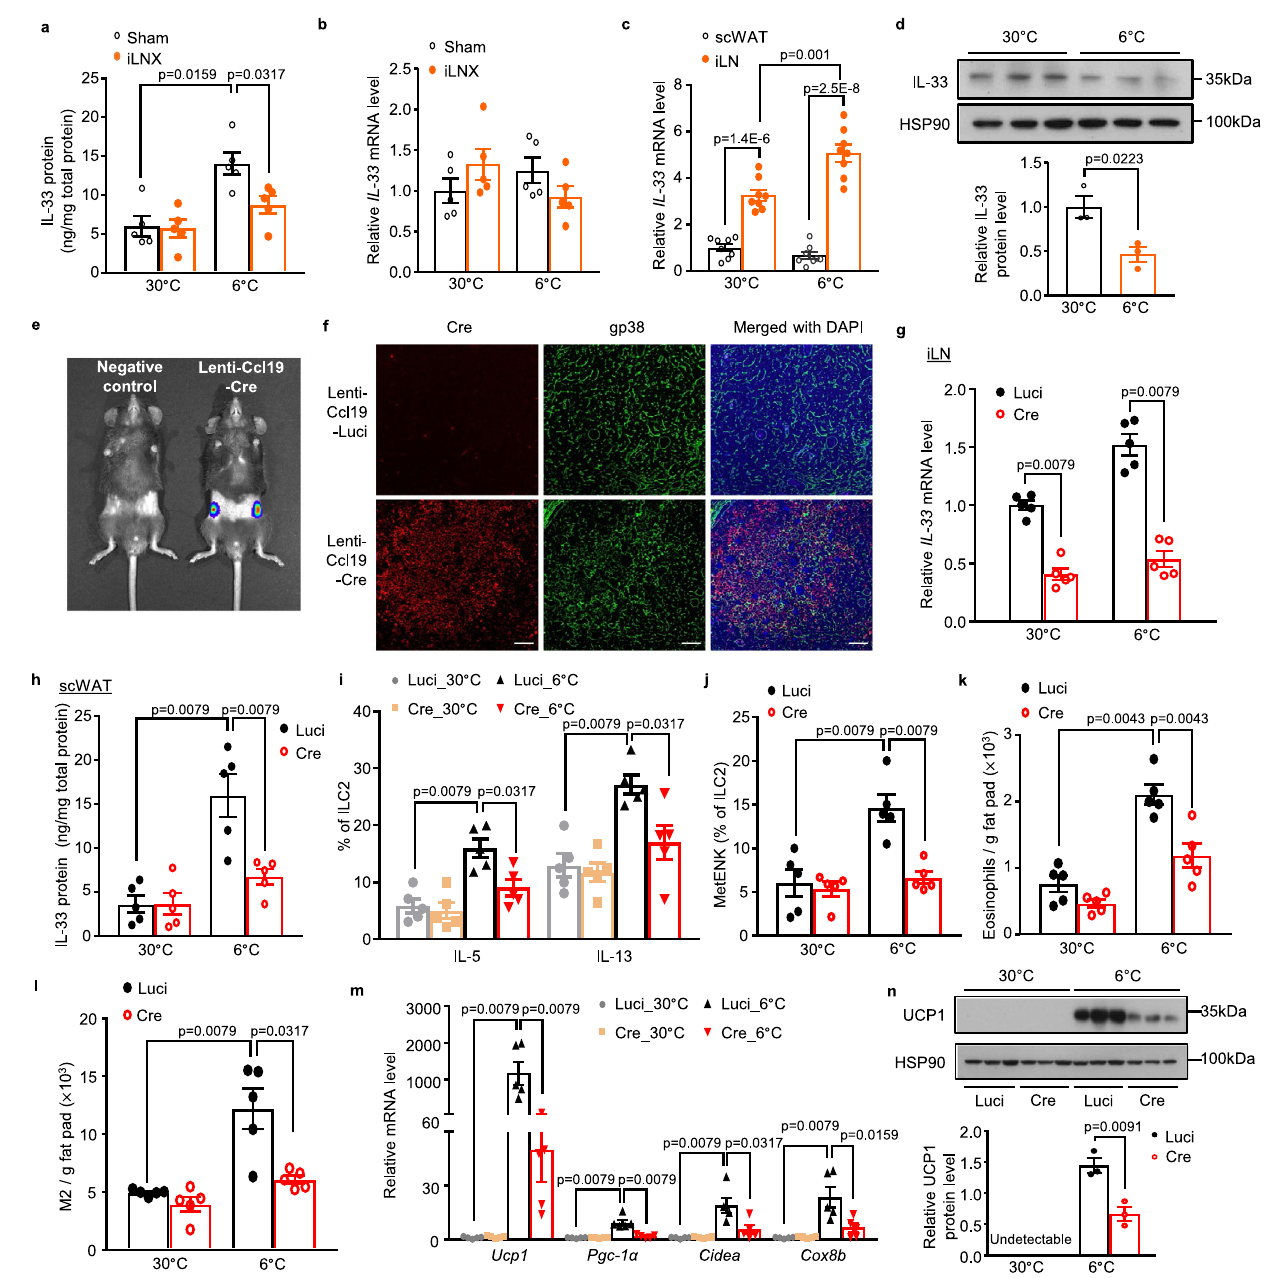
Fig. 3 | iLN FRC-derived IL-33 is indispensable for cold-induced activation of ILC2s and beiging of scWAT. a – d Sham-operated and iLNX male C57BL/6N mice wereexposedto6°Cor30°Cfor2days. a , b ELISAanalysisofproteinlevel(a)and themRNAexpressionofIL-33( b )inscWATofsham-operatedandiLNXmice( n =5). c The mRNA level of IL-33 in scWAT and iLN ( n =8). d IL-33 protein level in iLN determined by Western blot (top) and densitometric quanti fi cation of IL-33 (bot- tom) ( n =3). e – n Lentivirus encoding FLAG-tagged Cre and luciferase (Lenti-Ccl19- Cre)orluciferase only(Lenti-Ccl19-Luci)drivenby the Ccl19promoterwas directly injected into iLNs (7.5×10 6 Transduction Units [TU] per side) of eight-week-old male IL33 fl / fl mice. Seven days after lentiviral injection, mice were housed at 30°C for 3 weeks followed by 2-day cold exposure (6°C) or continued to be housed at 30°C for another 2 days. e IVIS Lumina imaging analysis showing luminescence intensity in mice with (Lenti-Ccl19-Cre) or without lentivirus injection (negative control) after intraperitoneal injection of luciferin (150mg/kg) for 10min.